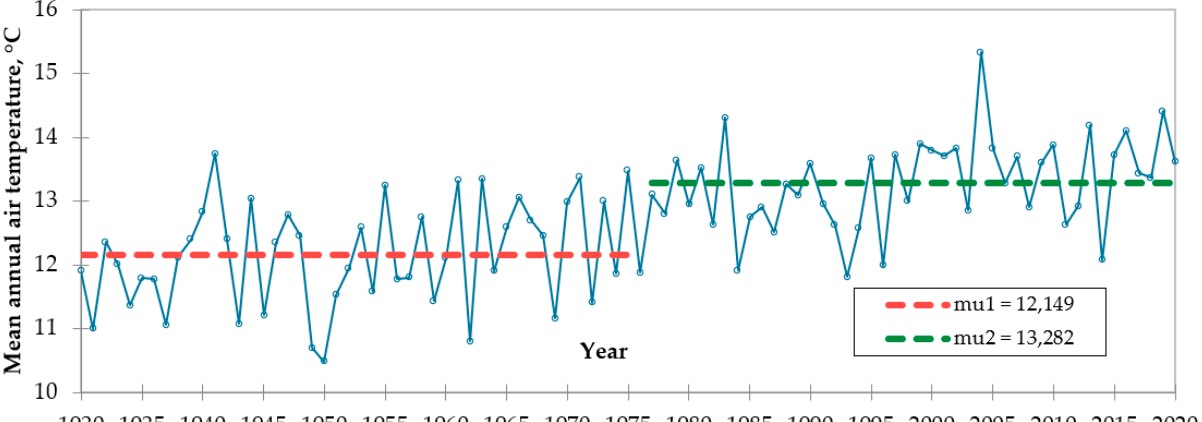
Figure 2. Mean annual air temperature at the Khiva meteorological station in 1928–2020 (point of change in 1984).